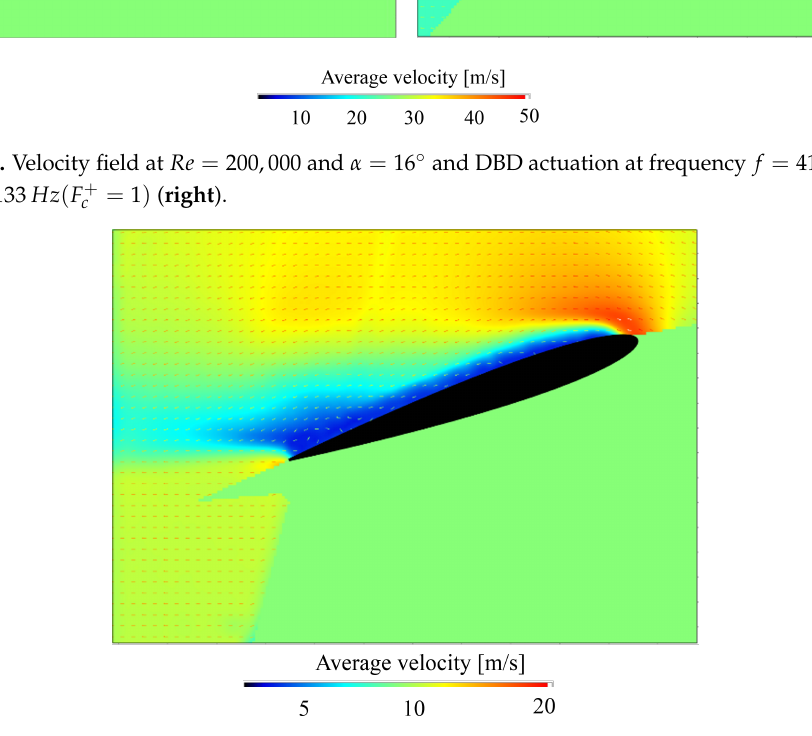
Figure 26. Velocity field at Re = 100,000 and α = 16 ◦ and DBD actuation at F + c =